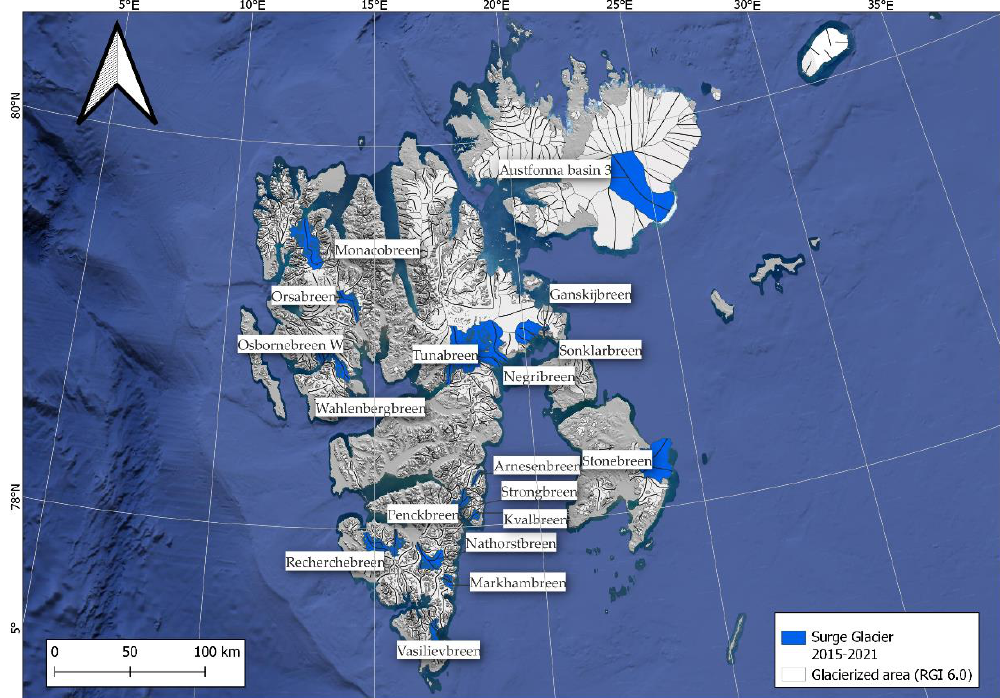
Figure 6. Distribution of active Surges detected in this study from 2015 – 2021 (dark blue).